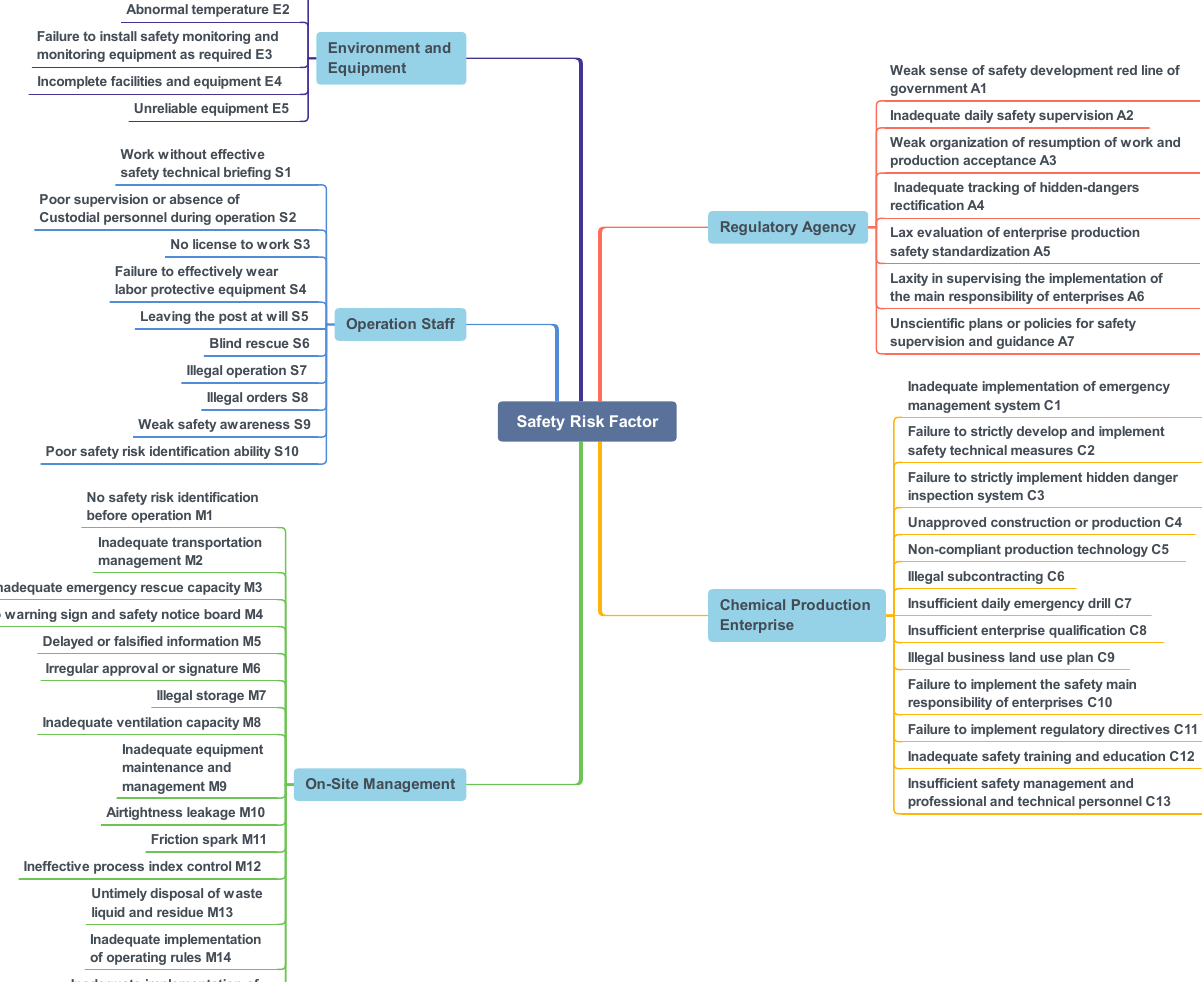
Figure 9. The combinations of keywords and non-key feature words.